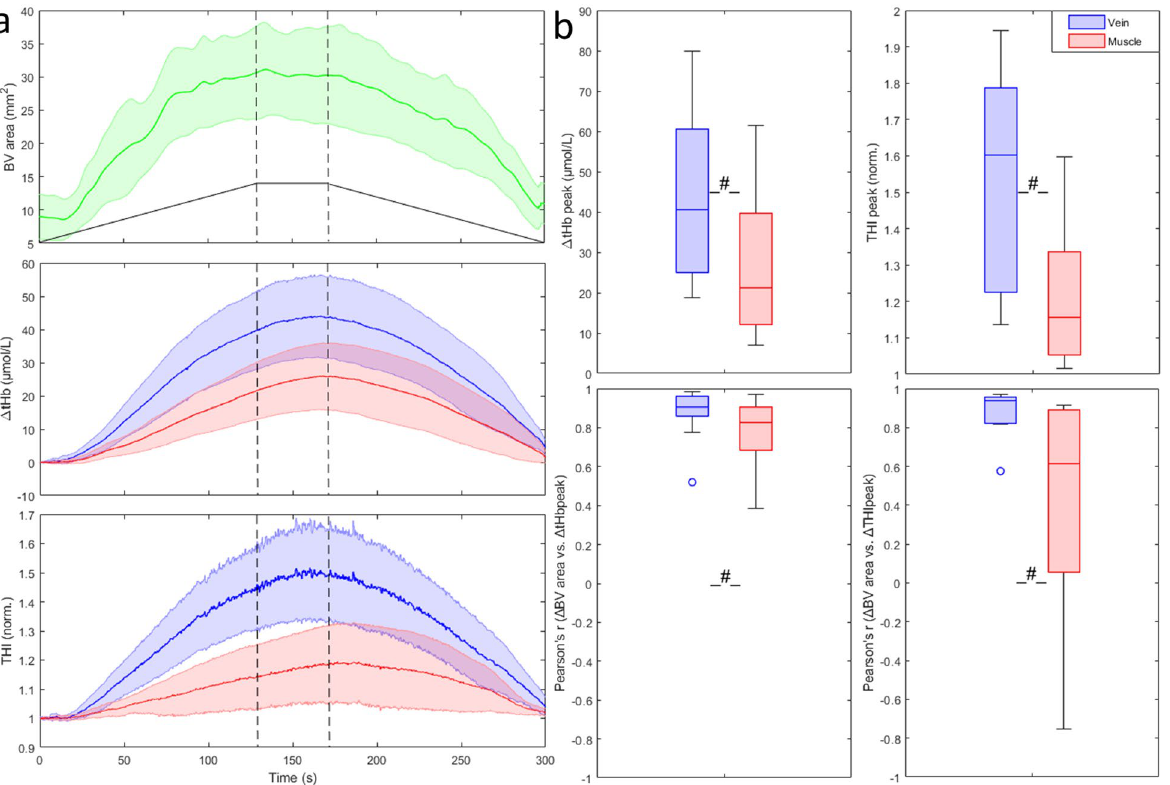
Figure 2. ( a ) Average response to slow venous occlusion of the cross-sectional area of the basilic vein (green) and of tHb and THI as detected on the muscle (red) and on the vein (blue). Shaded areas represent the 95% confidence interval of the mean. The black trapezoid depicted in the top graph qualitatively reproduces the cuff pressure during inflation to 60 mmHg, plateau and subsequent deflation to 0 mmHg, while the vertical dashed lines indicate end of inflation (first one) and beginning of deflation (second one). ( b ) Peak response of blood volume indexes, collected from vein and muscle probes (top), Pearson’s coefficient of the correlation between changes in BV cross-sectional area and in blood volume indices (bottom). *p < 0.05; # p <